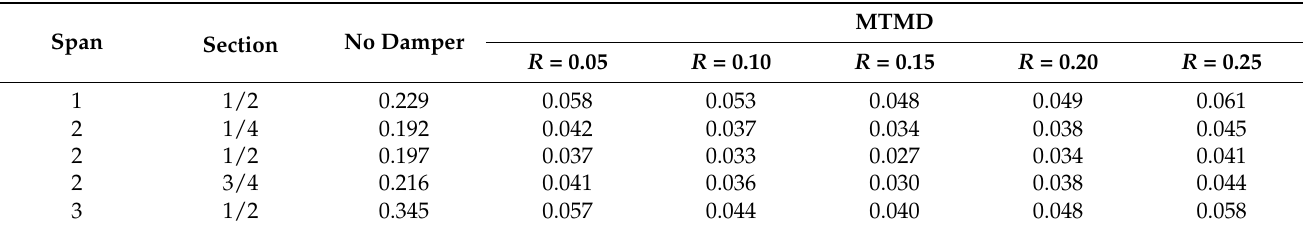
Table 8. Effect of the bandwidth on the lateral acceleration of the bridge under load case 5.